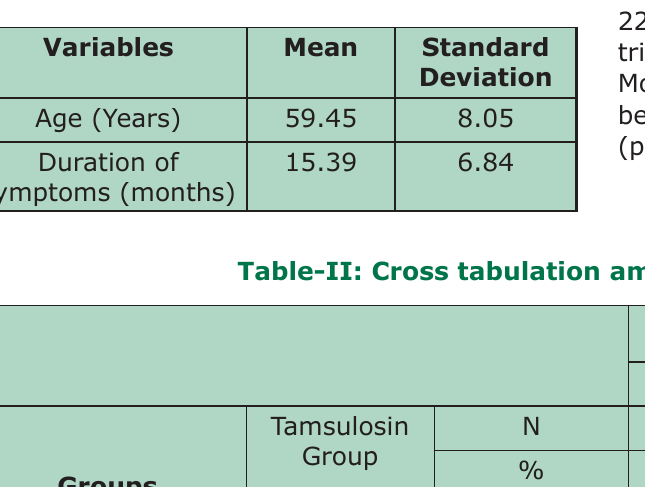
Table-I: Descriptive Statistics.